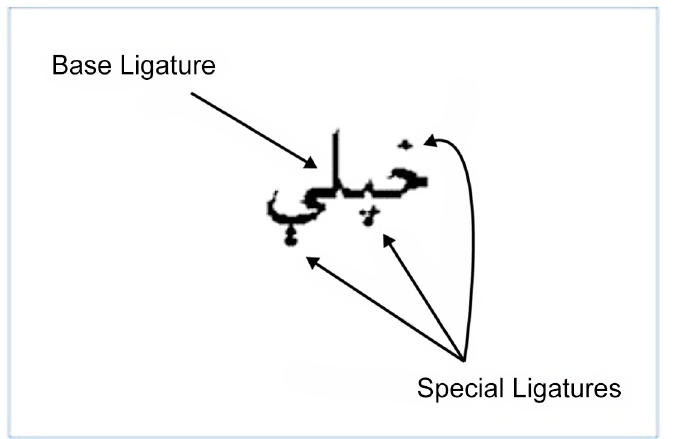
Fig 7. Base and Special